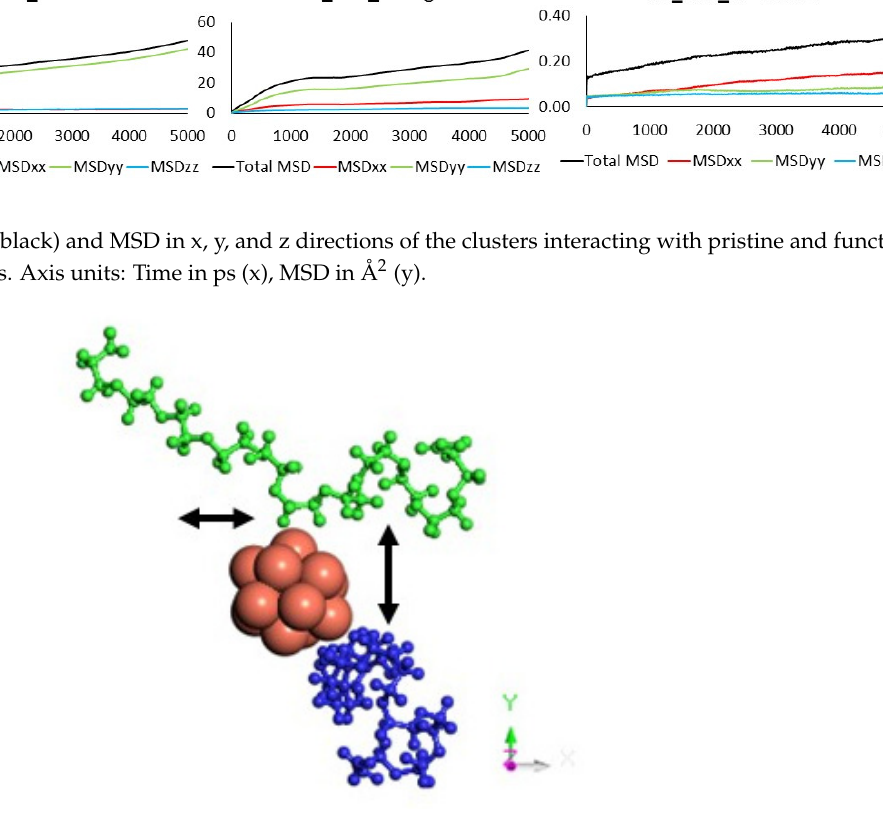
Figure 12. Motion in the xy plane of a Cu 13 cluster interacting with two PEG chains of a GO_PEG